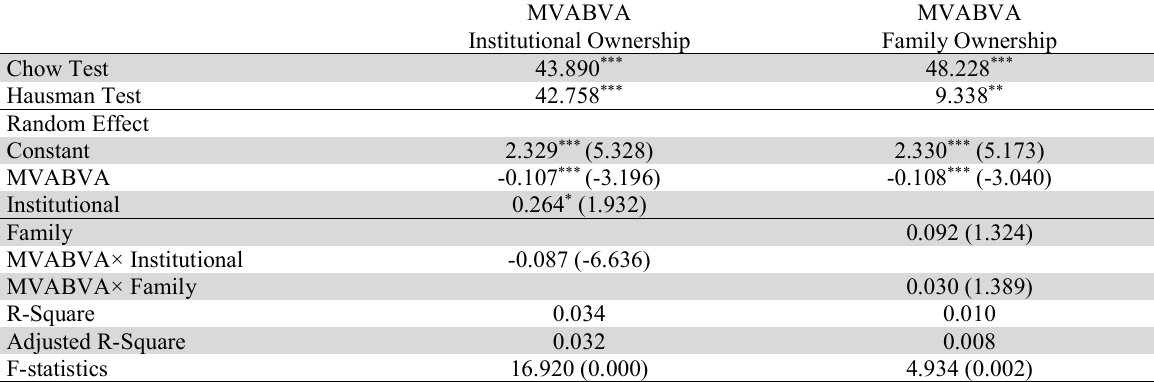
IOS Influence (MVABVA) and share ownership on